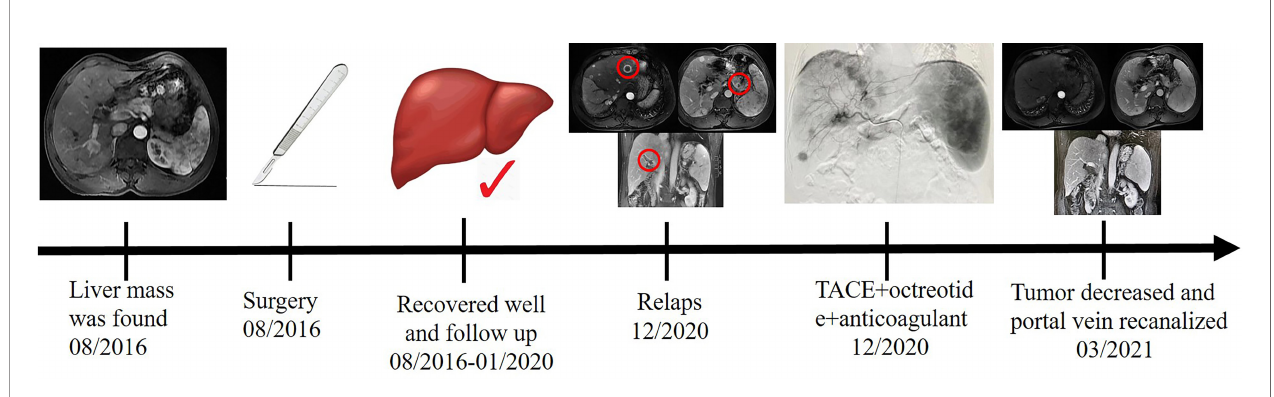
FIGURE 4 | A timeline containing data related to